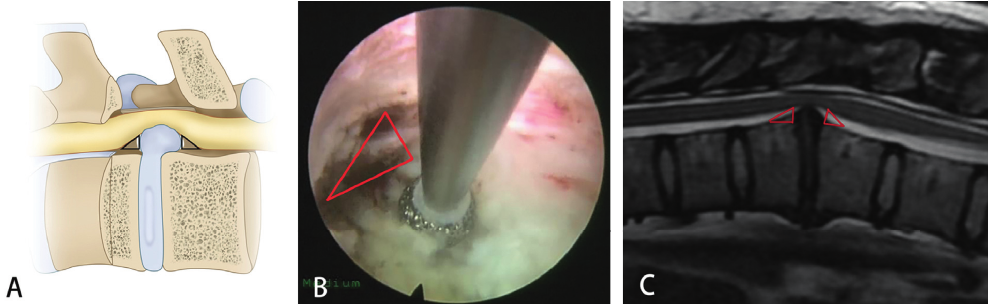
Figure 4: The “safe triangle zone” described by a diagram (a), endoscopic view (b), and MRI.